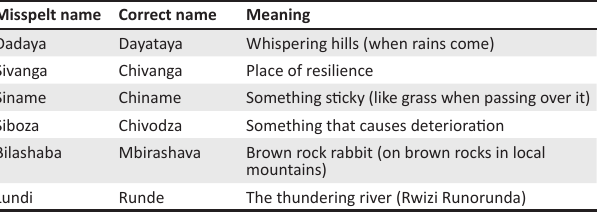
TABLE 1: Comparison of place name spelling conventions used by the colonisers in Zimbabwe and the indigenous community. Misspelt name Correct